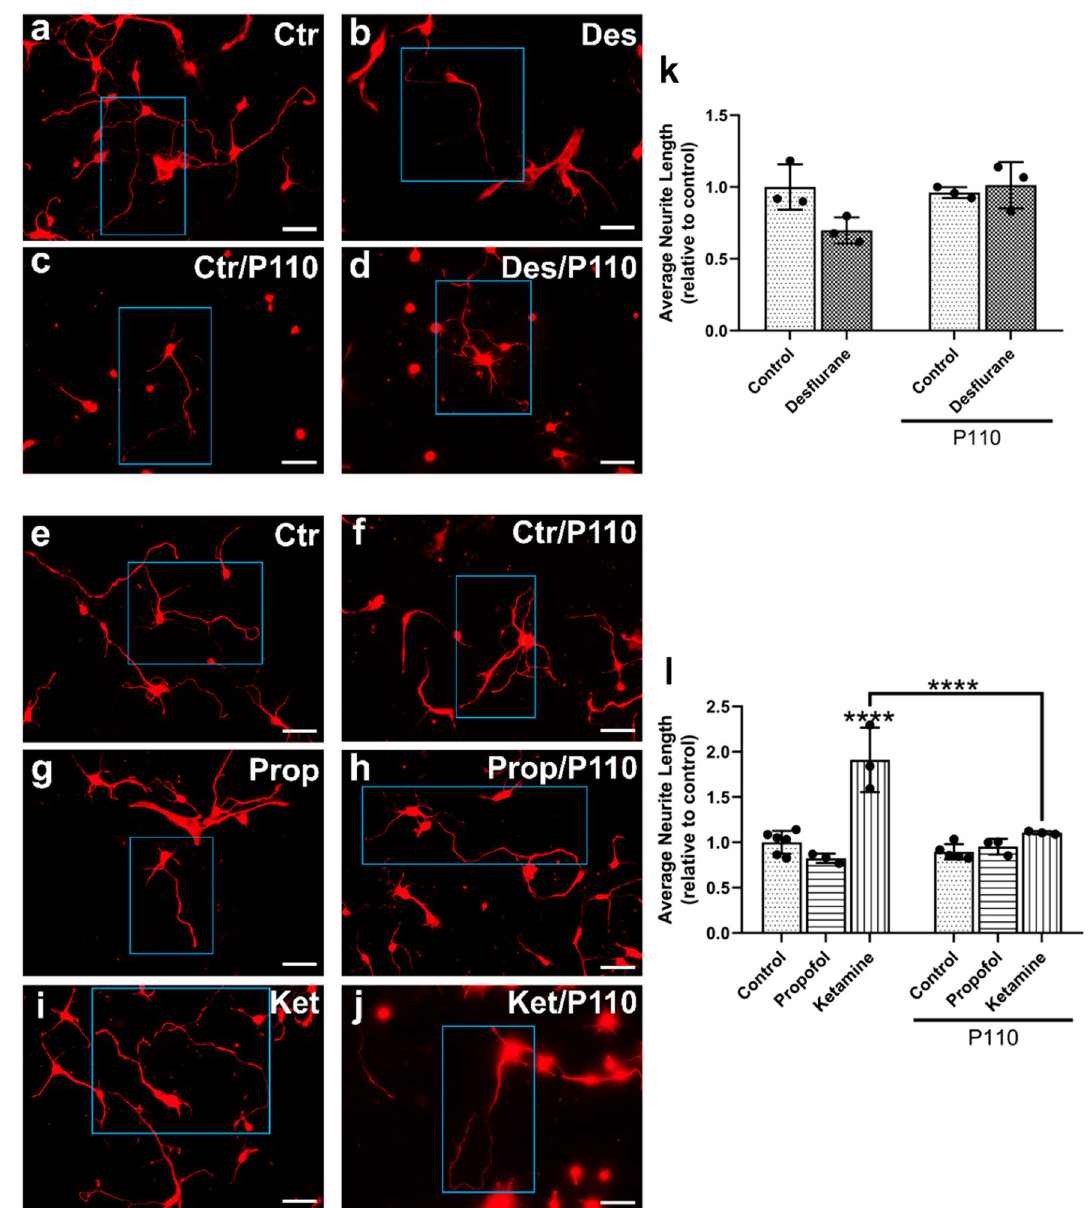
Figure 3. Ketamine increased average neurite outgrowth, which was attenuated by P110, whereas neither desflurane nor propofol had any significant impact. Representative fluorescent images of cortical neurons stained for neurofilament at day in vitro 3 (a–j) . Quantification of average neurite length relative to control (k–l) . Exposure to 4.3 Vol% desflurane did not decrease average neurite lengths, whereas treatment with 10 µM propofol did not significantly affect neurite outgrowth. Treatment with 5 µM ketamine resulted in enhanced growth compared to control. P110 alone did not affect neurite outgrowth wheras P110 pre-treatment mitigated ketamine-induced changes. P110 treatment followed by propofol or desflurane did not differ from control. Two-Way ANOVA. **** p < 0.0001 as determined by pairwise comparison of post-hoc tests. Bars indicate ± SD measured across biological replicates. Each data point indicates the mean average neurite lengths per biological replicate. Scale bars indicate 50